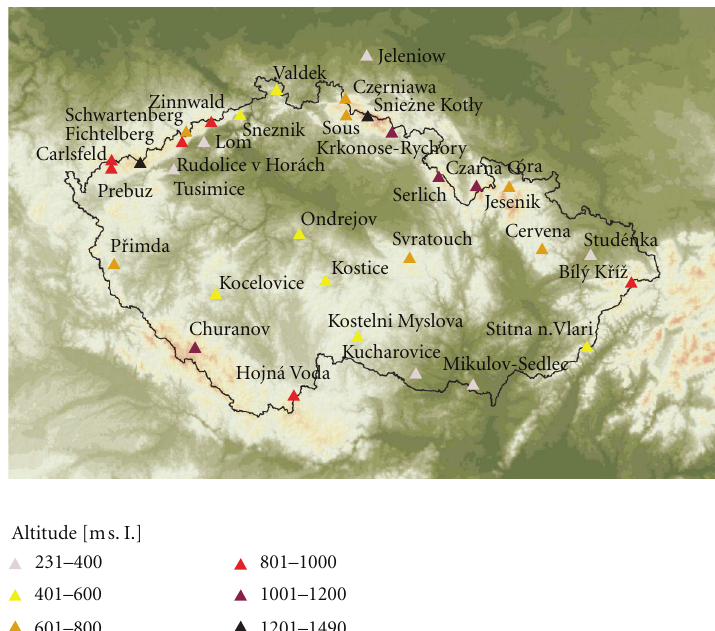
Figure 1: Sites with online monitoring of ambient O 3 concentrations ranked according to altitude.